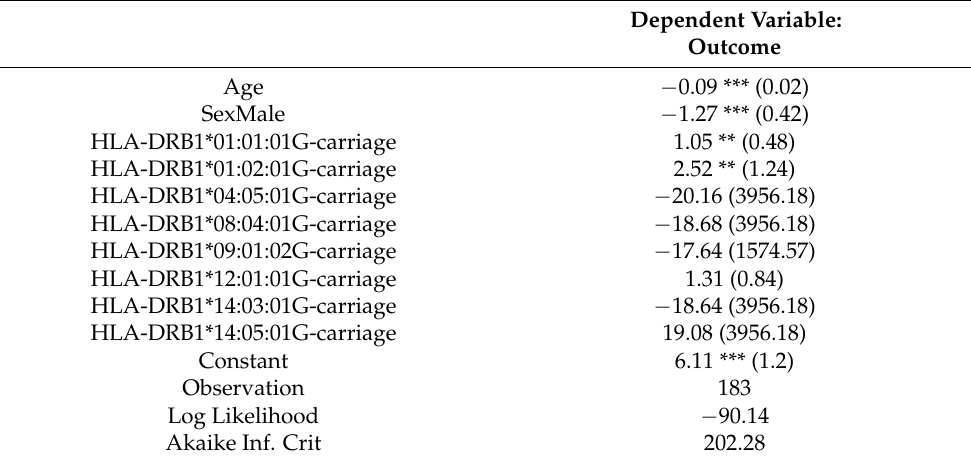
Table 12. Coefficients for “Best” model for locus